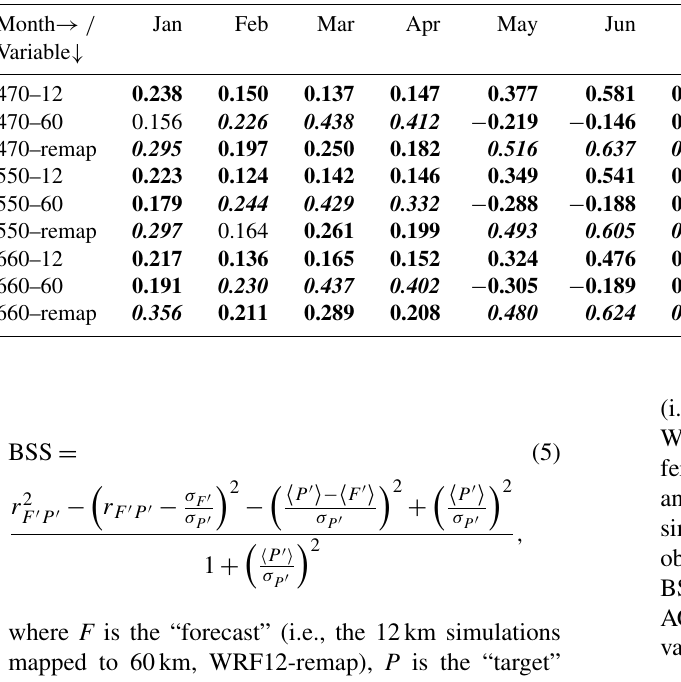
Figure 1. Probability density function of once daily AOD at a wavelength ( λ) of 550nm for (a) MODIS, (b) WRF60 and (c) WRF12 and WRF12-remap during the year 2008. (d–f) Taylor diagrams of mean monthly AOD at wavelengths ( λ) of (d) 470, (e) 550 and (f) 660nm as simulated by WRF-Chem at different resolutions (black diamonds = WRF60 and red dots = WRF12-remap) relative to MODIS observations. The numbers by each symbol denote the calendar month (e.g., 1 = January). Table 2. Spearman correlation coefficients ( ρ) between AOD at wavelengths ( λ) of 470, 550 and 660nm from MODIS observations averaged over 12 or 60km and WRF-Chem simulations conducted at 60km (WRF60, shown in the table as − 60), at 12km (WRF12, shown in the table as − 12), and from WRF-Chem simulations at 12km but remapped to 60km (WRF12-remap, shown in the table as remap). Given WRF12-remap is obtained by averaging WRF12 when at least half of the 5 × 5 12km resolution cells contain valid data, ρ from WRF60 and WRF12-remap may be computed on slightly different observations and sample size. The bold text denotes correlation coefficients that are = 4 . 63 × 10 − 4 is significant). The italic typeface is a visual significant at α = 0 . 05 after a Bonferroni correction is applied (i.e., p ≤ 0 . 05 9 × 12 guide that shows for each month and λ the model output that has highest ρ with